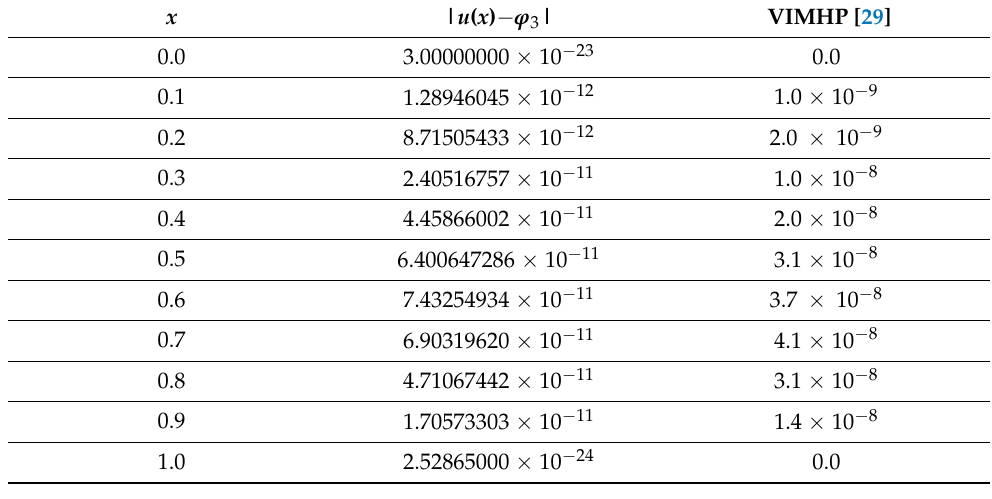
Table 3. The absolute error between the exact solution and the approximate of ϕ 3 in Example 3.